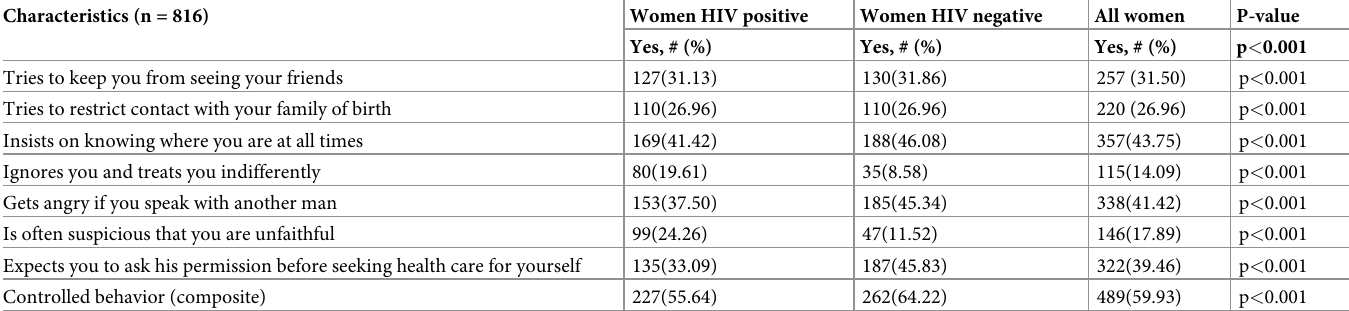
Table 2. Controlling behaviours by an intimate partner against women living with and without HIV in Wolaita Zone, Southern Ethiopia, November-December 2018. Characteristics (n = 816)